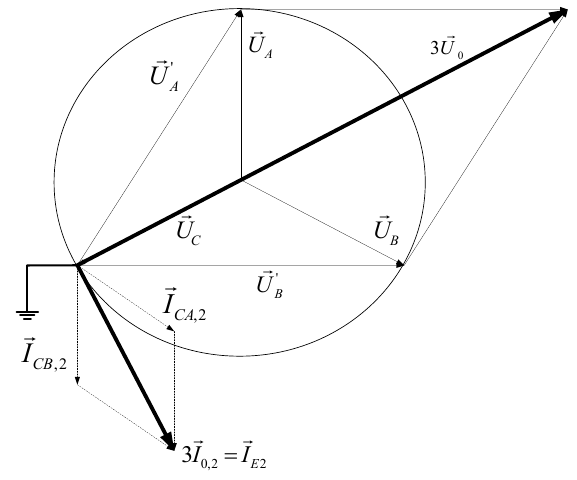
Figure 4. Vector diagram. Residual voltage and current in Line 1 with ground defect.